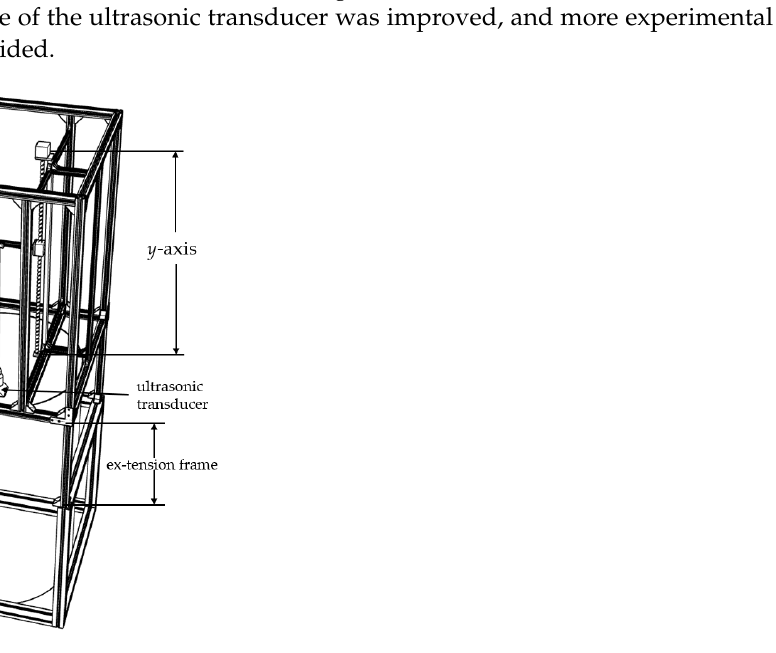
Figure 5. Longitudinal-ultrasonic-transducer calibration device with a height of 1200 ~ 1500